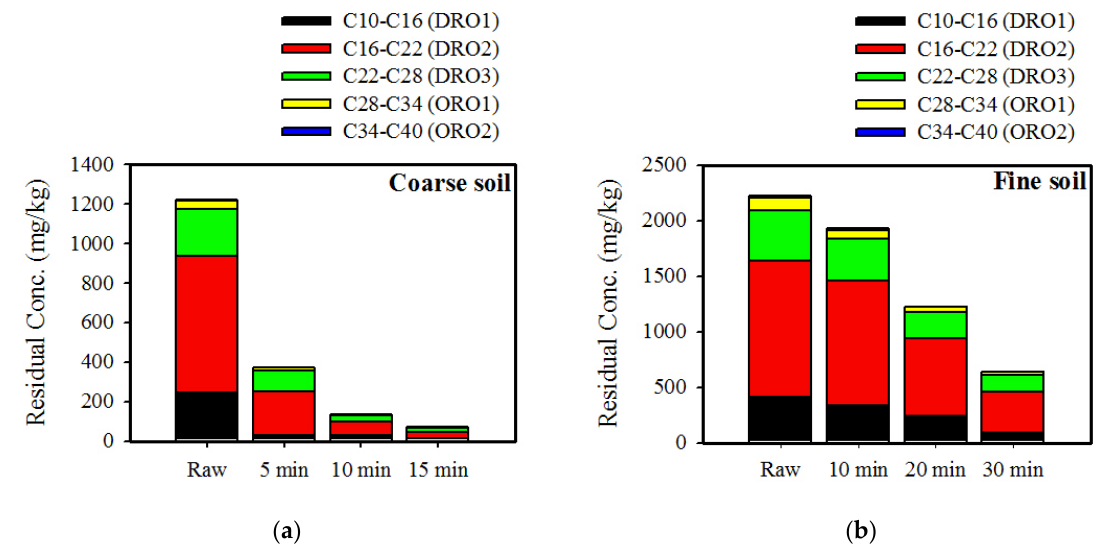
Figure 3. Residue concentration of different fractions in TPH as function of treatment time for different particle sizes. ( a ) Coarse soil (>0.106 mm) and ( b ) fine soil (<0.106 mm).